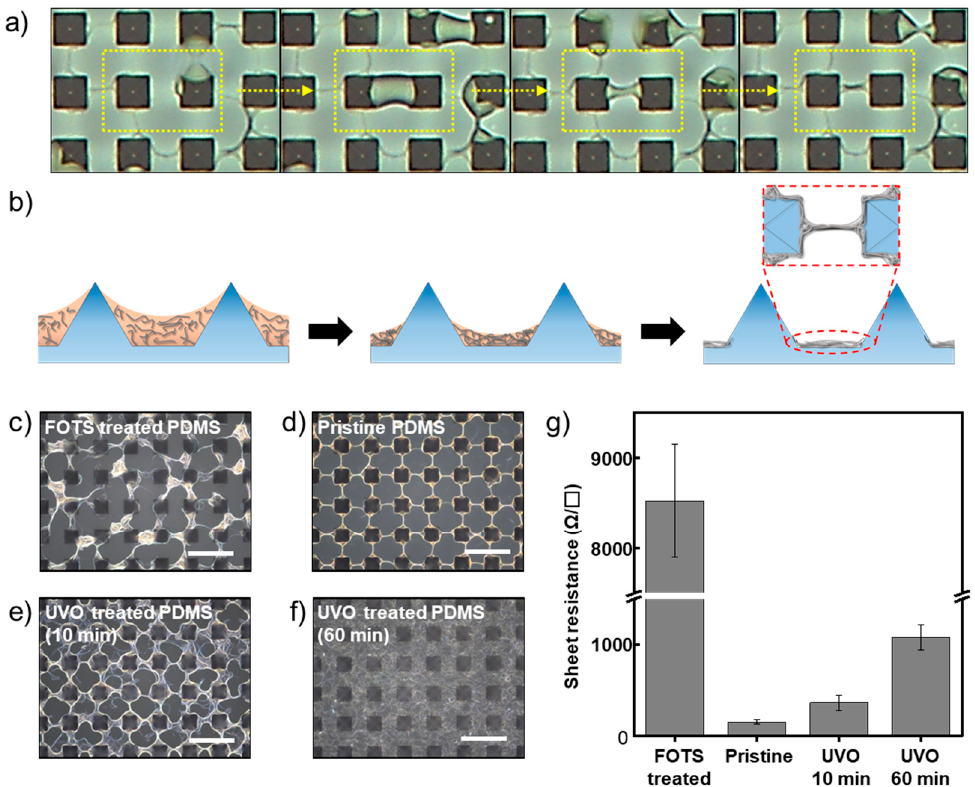
Figure 2. ( a ) In situ captured images during AgNW deposition by spray coating. ( b ) Schematic of the potential formation mechanism of the BSS bundle mesh. ( c – f ) Images of deposited AgNW on microstructured substrates with various surface energy. Scale bar: 30 μ m. ( c ) FOTS-treated PDMS; ( d ) pristine PDMS; ( e ) UVO (10 min) treated PDMS; ( f ) UVO (60 min) treated PDMS. ( g ) Sheet resistances of the AgNW-deposited substrates are shown in Figure 2c–f. The sheet resistance is the mean value of 5 samples, and the error bar indicates standard deviation.